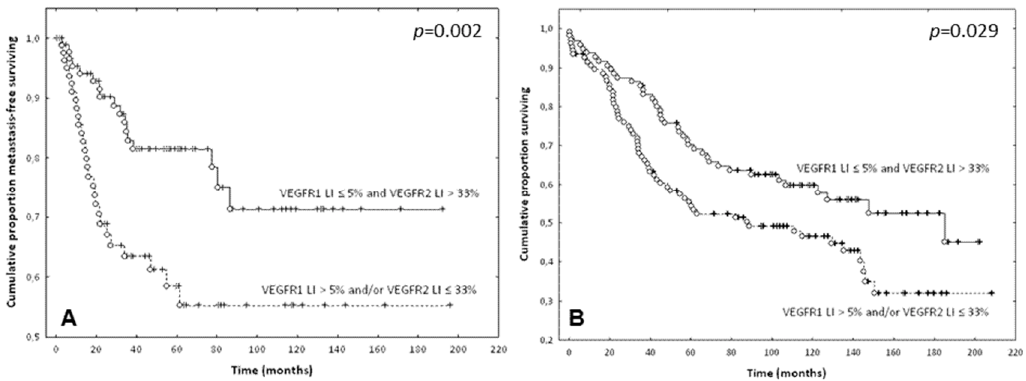
Figure 5. Prognostic value of the combination of the VEGFR ‐ 1 and VEGFR ‐ 2 expression in ECs of CRC: ( A ) Metastasis ‐ free survival curves of patients dichotomized based on the combination of VEGFR ‐ 1 ‐ LI and VEGFR ‐ 2 ‐ LI ( p = 0.002). ( B ) Overall survival curves of patients dichotomized in a similar manner ( p = 0.029). Complete and censured data are shown as dots and crosses, respectively. Solid lines identify patients with ECs characterized by a VEGFR ‐ 1 LI ≤ 5% and a VEGFR ‐ 2 LI > 33%. Dotted lines identify patients with ECs characterized by a VEGFR ‐ 1 LI > 5% and/or a VEGFR ‐ 2 LI ≤ 33%.